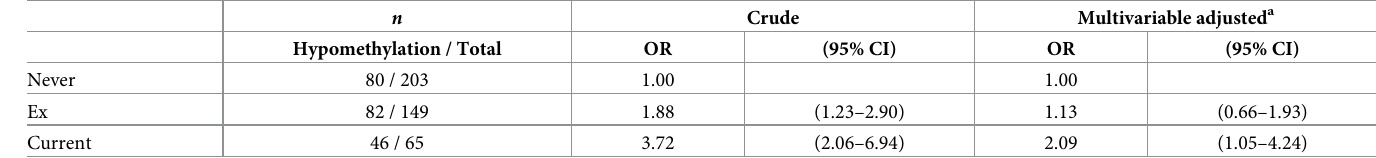
Table 3. Odds ratios (ORs) and 95% CIs for hypomethylation of the TXNIP gene according to smoking habits.